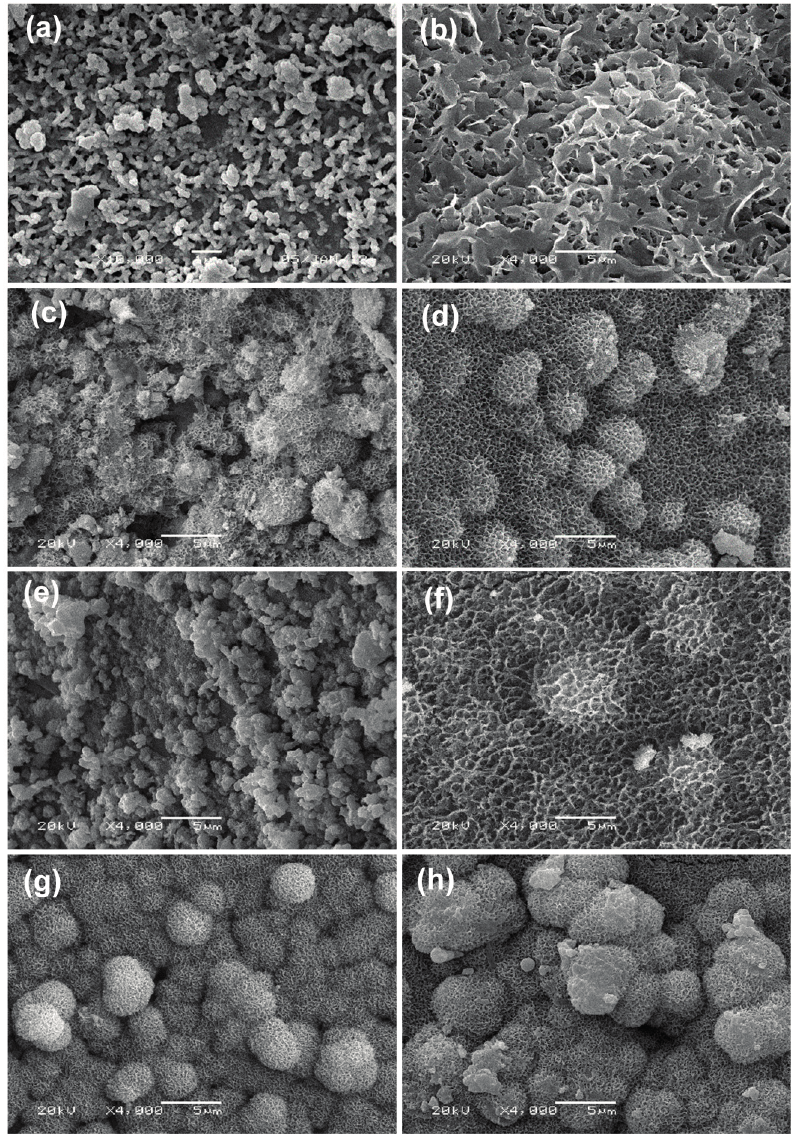
Figure 4. SEM images of the scaffolds after immersion in simulated body fluid (SBF) for 2 weeks and 4 weeks: ( a , b ) β -TCP; ( c , d ) β -TCP/SiO 2 ; ( e , f ) β -TCP/MgO and ( g , h ) β -TCP/SiO 2 /MgO. 2 weeks: ( a , c , e , g ); 4 weeks: ( b , d , f , h